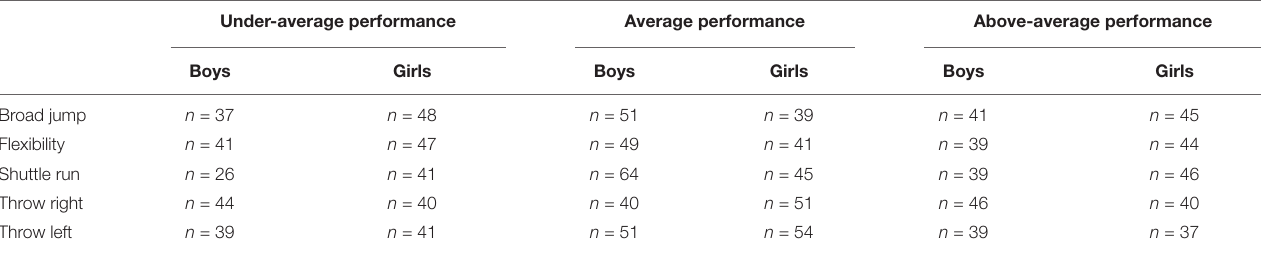
TABLE 4 | Frequency of under-average, average and above-average physical fitness performance in each